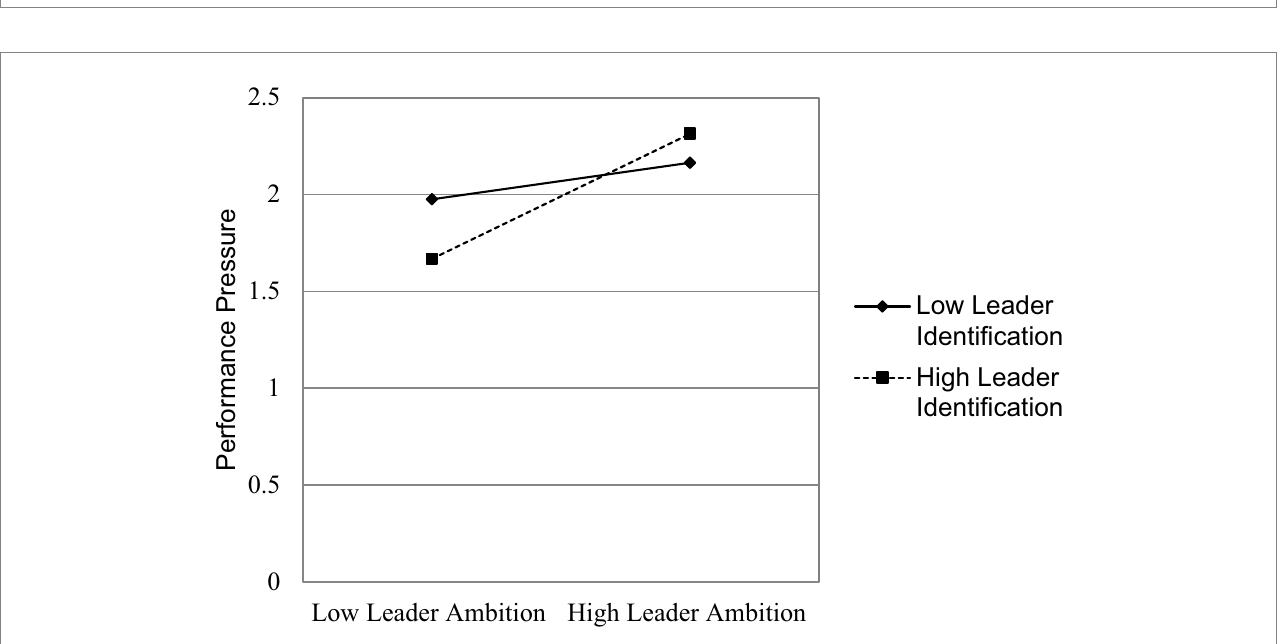
FIGURE 4 Study 2: interaction of leader ambition and leader